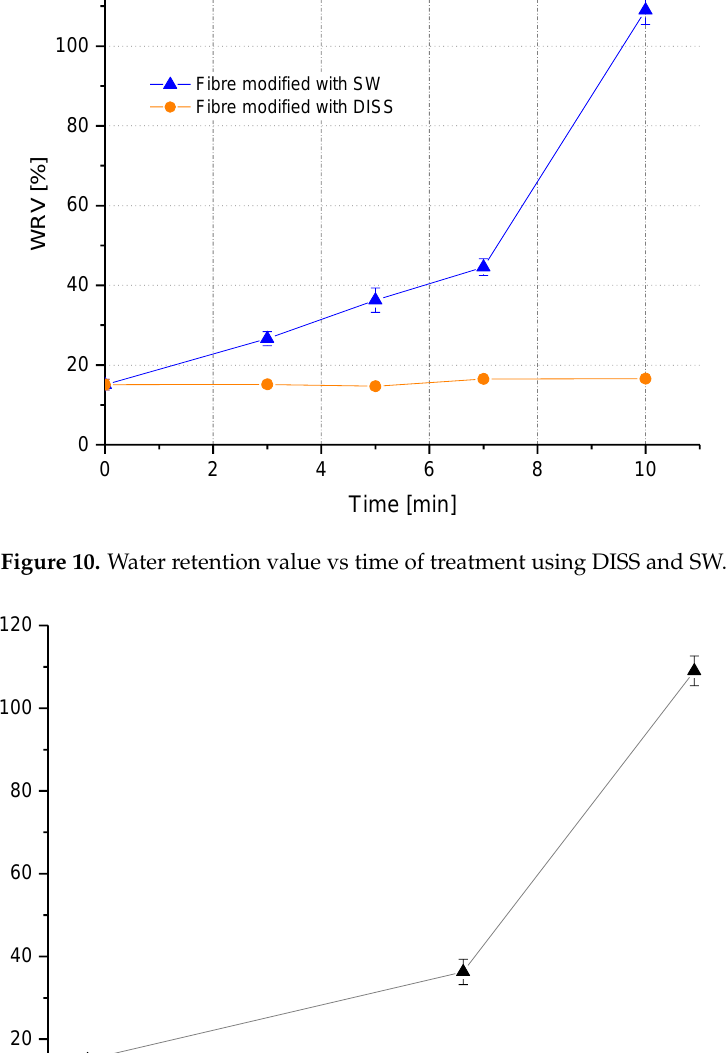
Figure 11. Water retention value vs diameter change in percentage after 10 min treatment with SW.